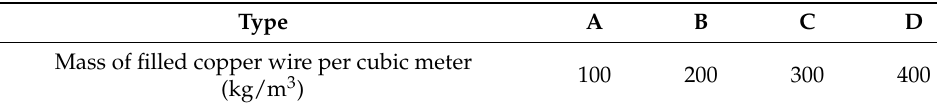
Table 2. Isothermal container with different copper wire filling density.